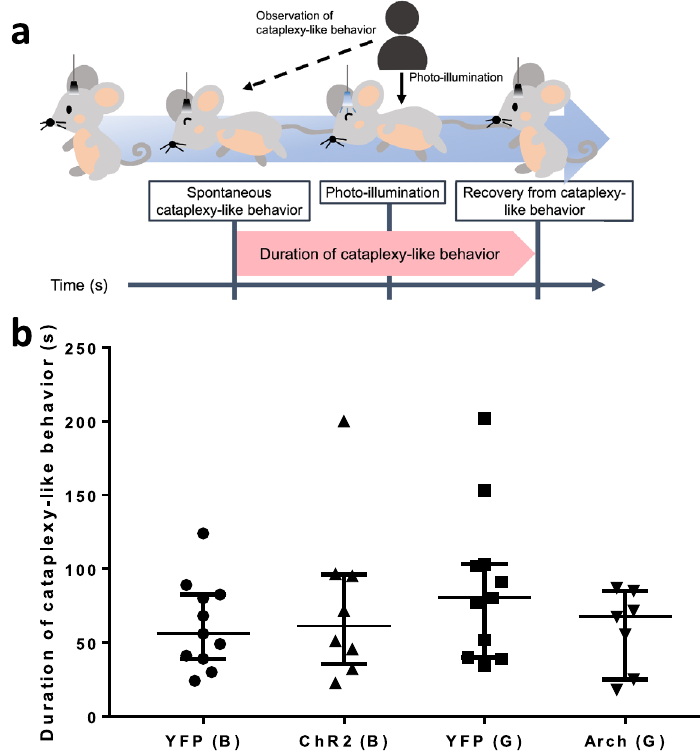
Figure 4. Effect of activation/inactivation in the rostral NAc shell on the spontaneous cataplexy-like behavior. ( a ) Schematic explanation of observation of photo-illumination on the spontaneous cataplexy-like behavior. In some experimental sessions, the mouse was given immediate (15.7 ± 1.3 s) photo-illumination when the beginning of spontaneous cataplexy-like behavior was observed. The possible modifying effect of blue/green photo-illumination on the spontaneous cataplexy-like behavior was examined. ( b ) Duration of cataplexy- like behavior when the mouse was given photo-illumination at the beginning of spontaneous cataplexy-like behavior. The plot showed the median duration of cataplexy-like behavior when the mouse was given photo- illumination at the beginning of spontaneous cataplexy-like behavior. Blue/green photo-illumination in ChR2/ Arch group did not affect the duration of spontaneous cataplexy-like behavior (Kruskal–Wallis test, P = 0.4985, YFP (B) n = 11, ChR2 (B) n = 8, YFP (G) n = 11, Arch (G) n = 7). The data represent the median with an interquartile